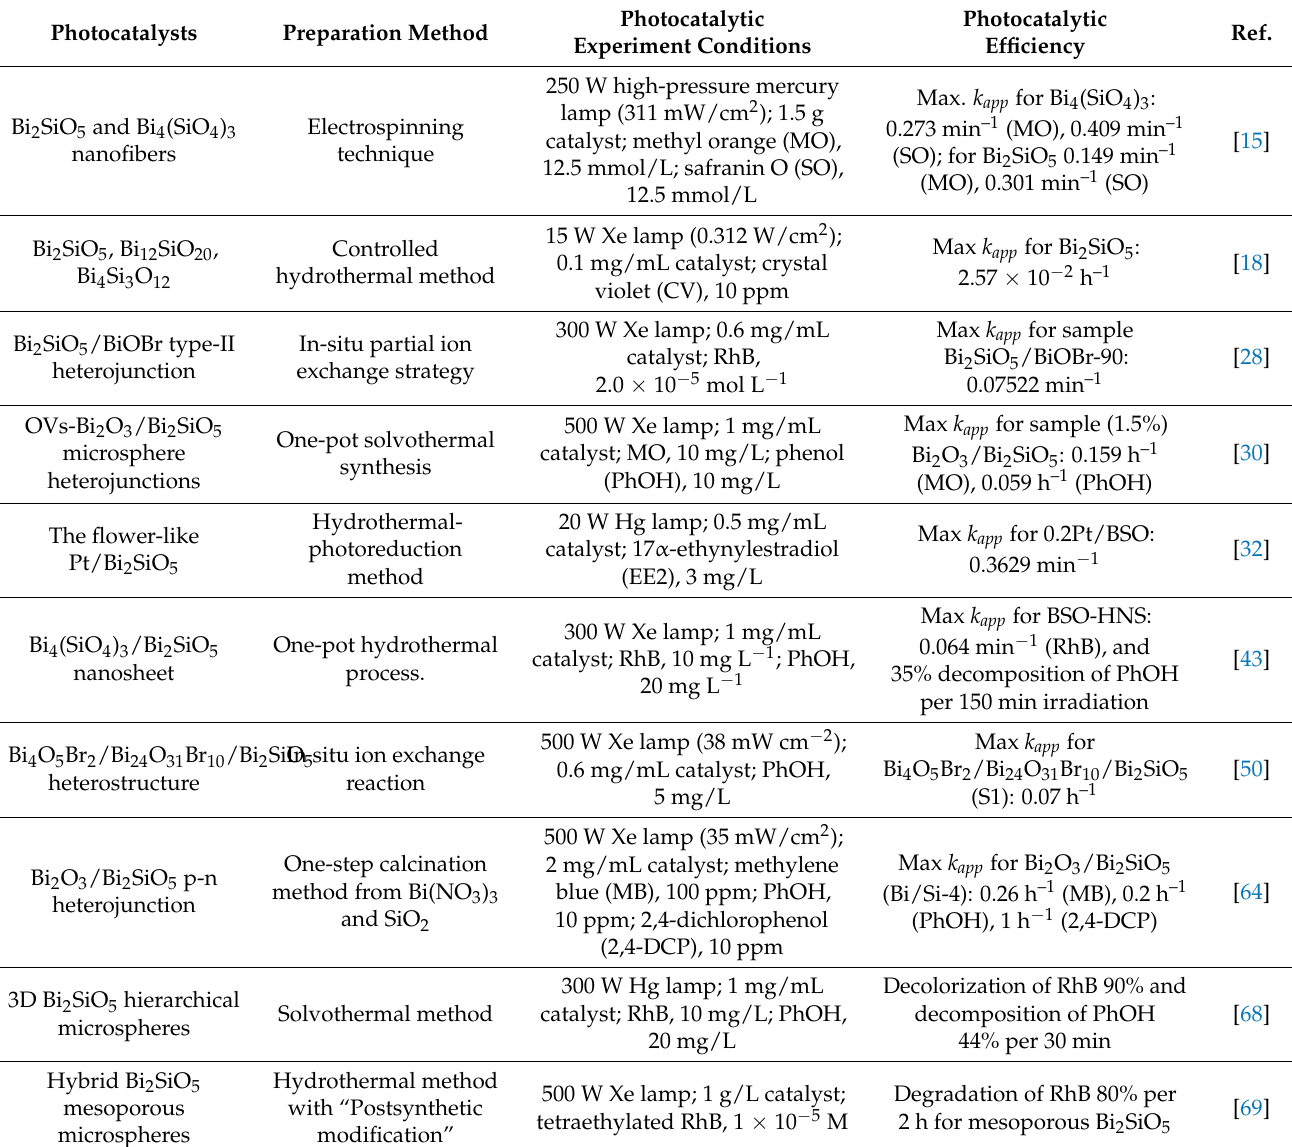
Table 3. Photocatalytic efficiency of complex oxides based on